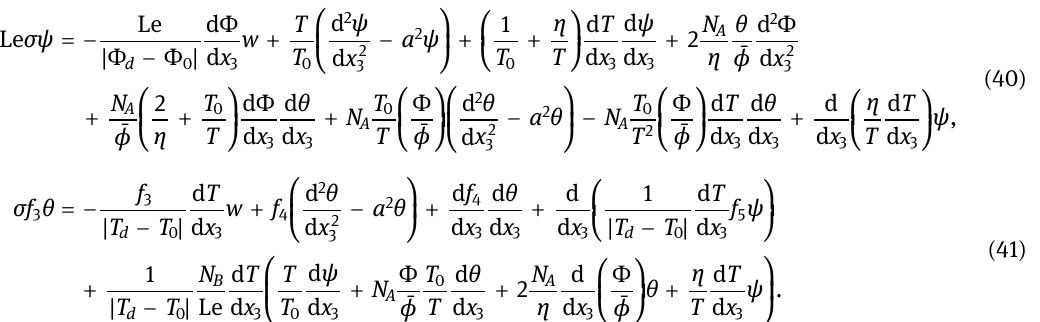
Figure 2 for the same nano fl uid using the model of Brinkman and Hamilton - Crosser. In this fi gure, we can see that the layer of DW/cupric oxide nano fl uid is more stable than the layer of DW/alumina nano fl uid, for all values of the nanoparticle volume